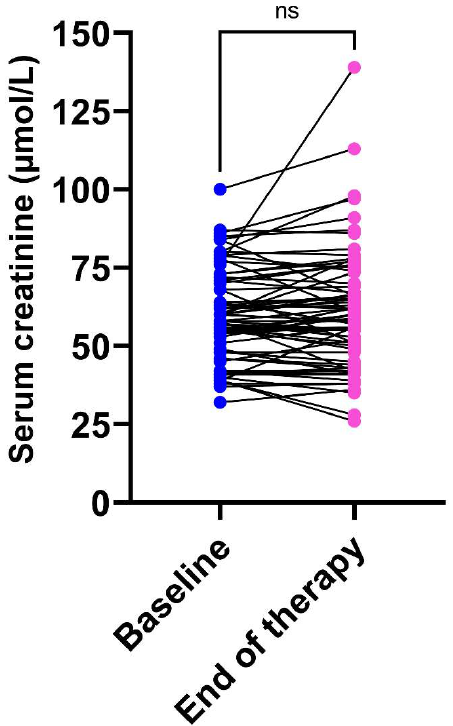
Figure 4. Individual changes in serum creatinine during tobramycin therapy ( n = 69). Abbreviation: ns, non-significant.